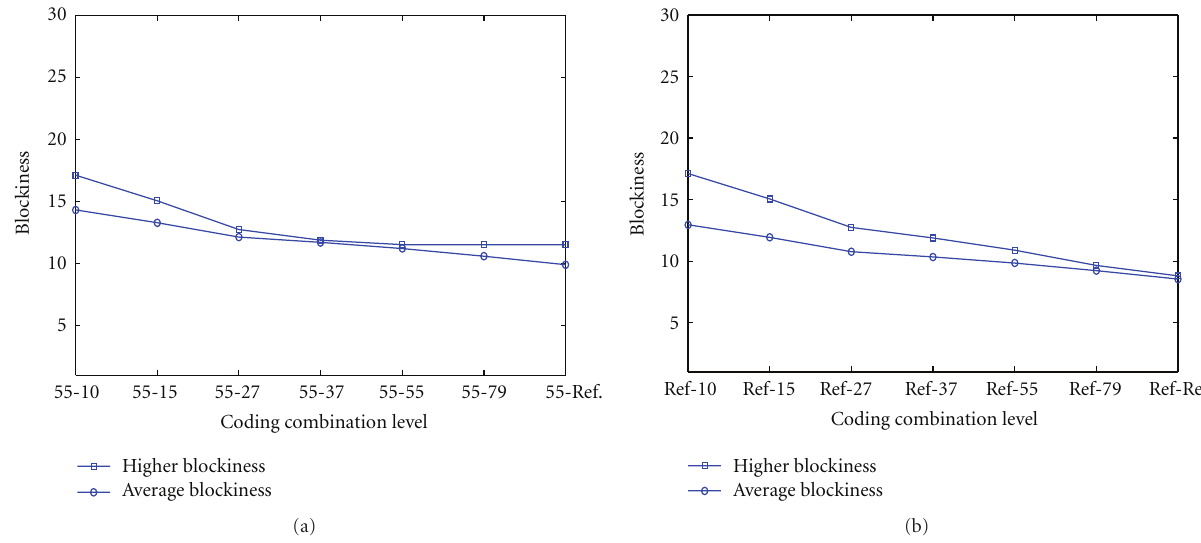
Figure 3: Blockiness versus di ff erent coding levels for Cattle image pairs (a) L, R: QS55-Seven di ff erent coding levels. (b) L, R: Ref-Seven di ff erent coding